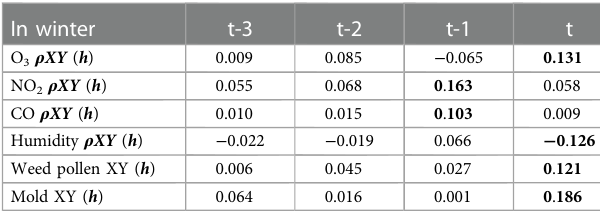
Tree pollen ρ XY ( h ) Bold values represent highest cross-correlation coef fi cients. t-n: n weeks ago.